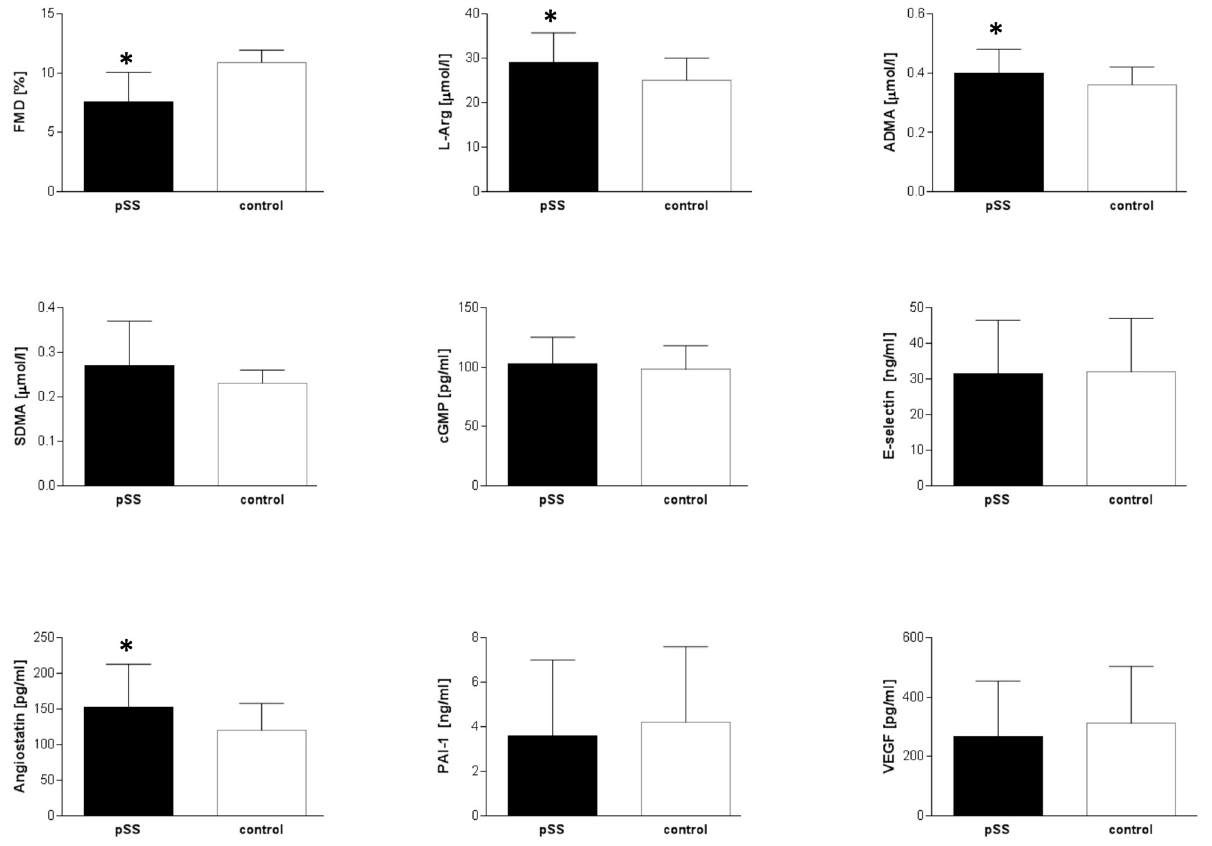
Figure 2. Endothelial function profile. Abbreviations: ADMA—asymmetric dimethylarginine, cGMP—cyclic guanosine monophosphate, FMD—flow mediated dilation, PAI-1—plasminogen activator inhibitor-1, SDMA—symmetric dimethylarginine, VEGF—vascular endothelial growth factor, * p < 0.05 vs. control.